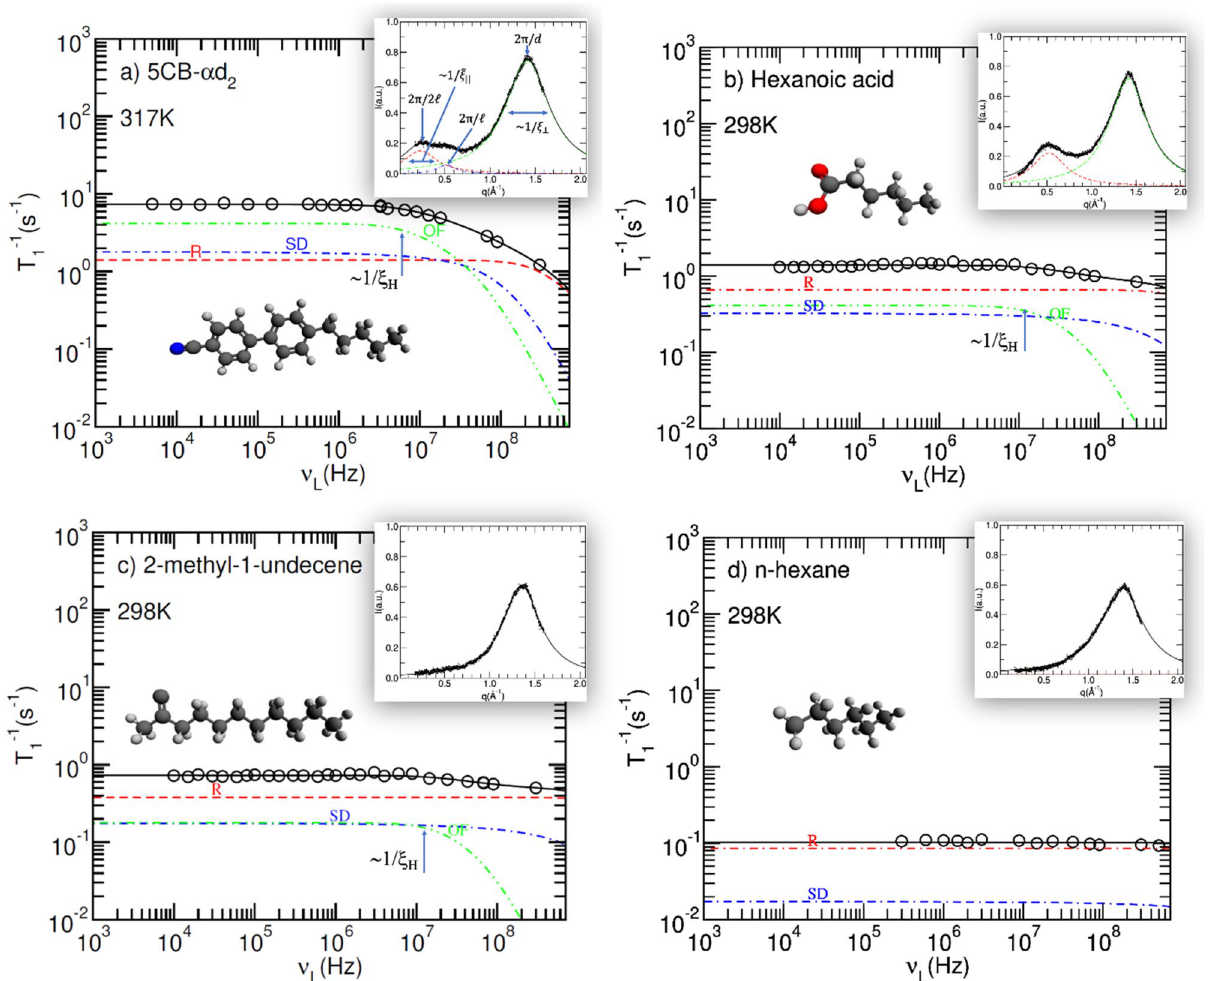
Figure 1. Proton longitudinal relaxation rate as a function of Larmor frequency for 5CB ( a ), hexanoic acid ( b ), 2-methyl-1-undecene ( c ), and n-hexane ( d ), together with the corresponding model fits. Contributions of individual relaxation mechanisms are shown separately (red dash: rotations/reorientations, R; blue dot-dash: self-diffusion, SD; and green double dot-dash: order fluctuations, OF), and as a sum (solid black line). Insets show the X-ray diffraction profiles at the corresponding temperatures, accompanied by the model fits .